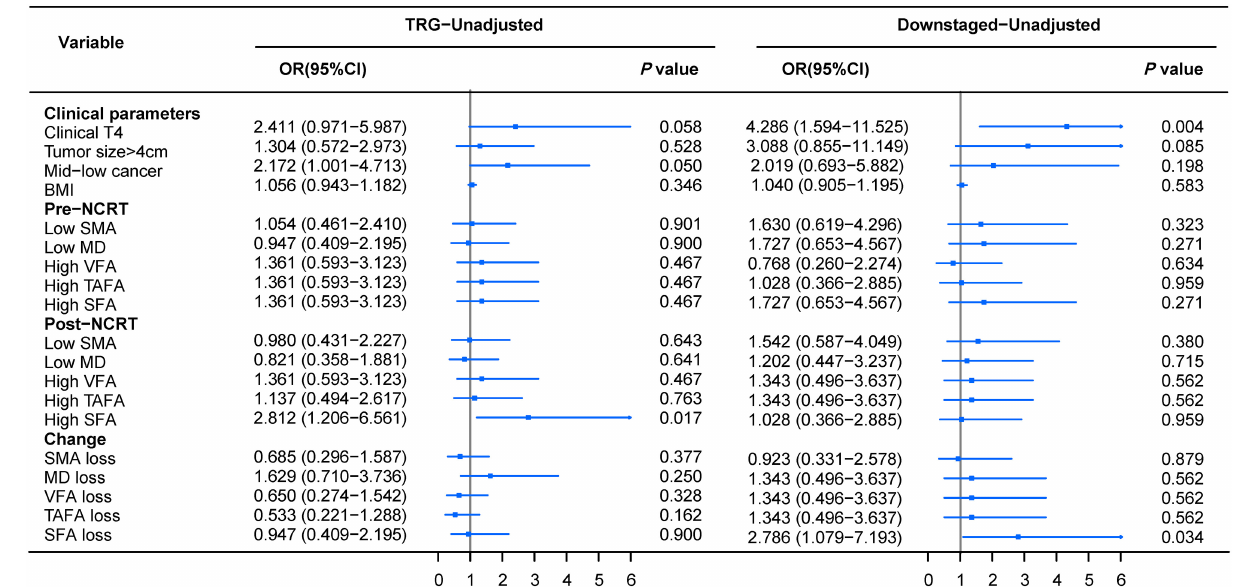
of other parameters ( Supplementary Figure 2A ).